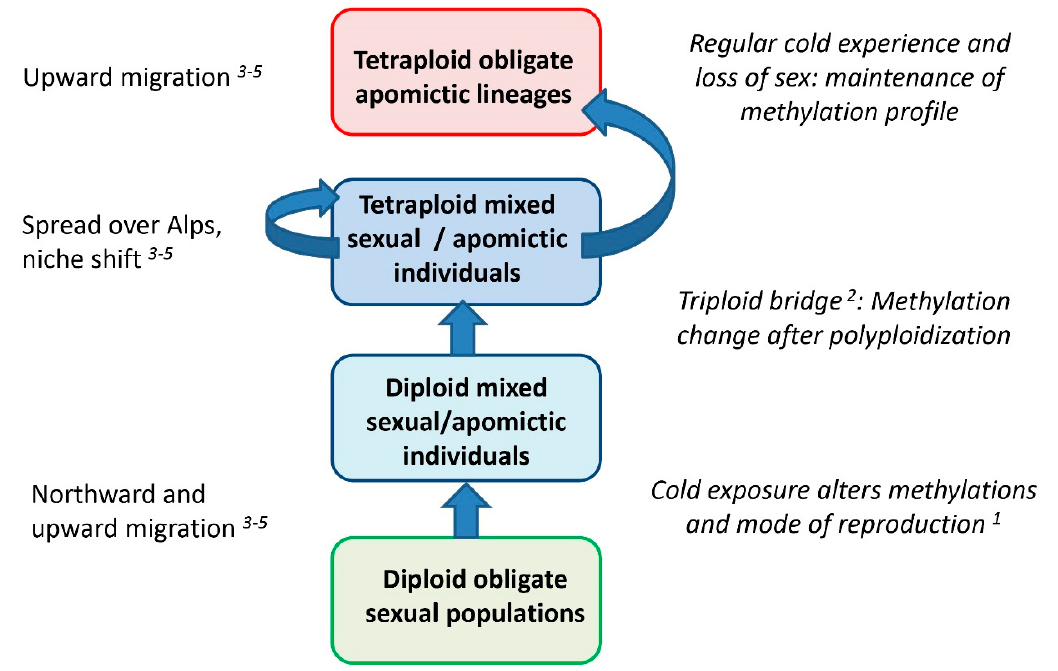
Figure 3. Hypothetical evolutionary scenario of the interplay of climatic conditions, polyploidization, and shifts to apomixis with methylation patterns, integrating previous publications: 1 [52], 2 [57], 3 [45], 4 [60], 5 [61].